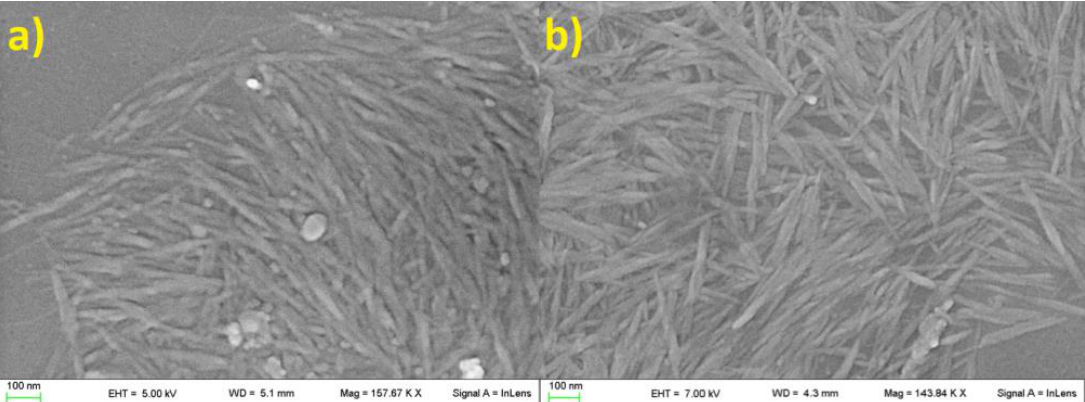
Figure 1. CNC-CH ( a ), CNC-EN ( b ), observed through SEM. No particular differences in size and shape were observed, other than the presence of a larger mass of impurities in CNC-CH samples.